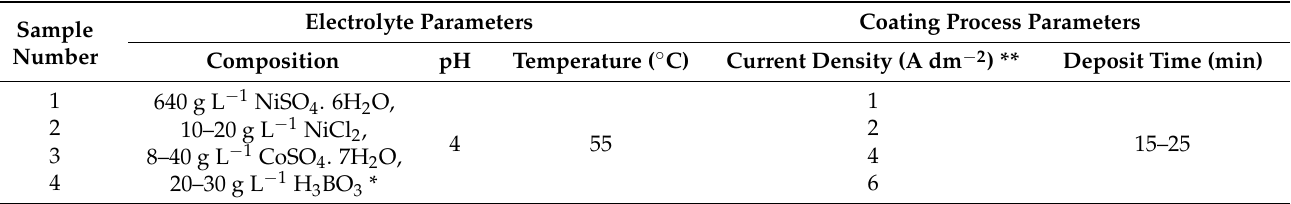
Table 1. Coating process parameters.